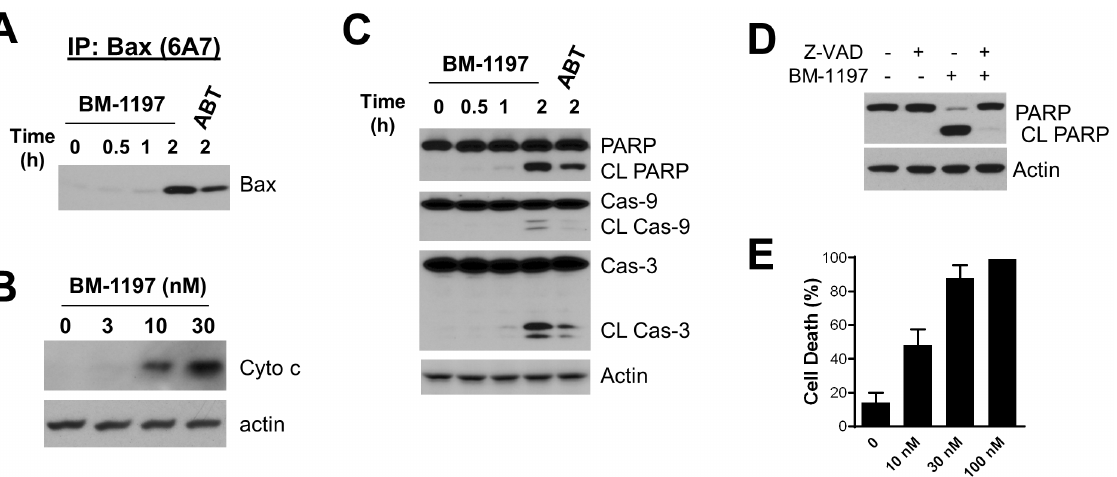
Figure 8. BM-1197 induces BAX translocation, cytochrome c release and cell death in H146 cells. (A) CHAPS lysed whole cell extracts from BM-1197 (100 nM)-treated H146 cells were immunoprecipitated with conformation-sensitive Bax specific antibody 6A7, and immunoprecip- itates were analyzed by immunoblotting. (B) H146 cells were treated with BM-1197 for 2 h and cytosolic fraction was isolated for immunoblotting. (C) Cells were treated with BM-1197 (100 nM) or ABT-263 (100 nM) for the indicated time points and whole cell extracts were analyzed by immunoblotting. (D) H146 cells were pretreated with DMSO or 40 m M of Z-VAD for 2 h, then treated with 200 nM of BM-1197 for 4 h for immunoblotting analysis. (E) Cells were treated with BM-1197 for 1 day and cell death was evaluated by trypan blue exclusion assay. Data are